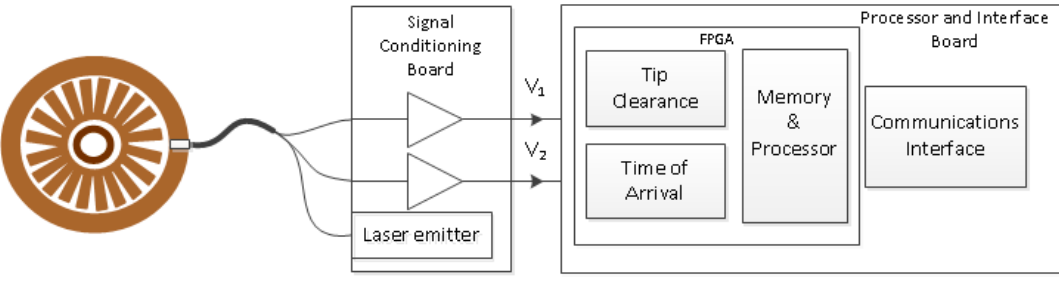
Figure 1. Architecture to monitor a bladed disk.